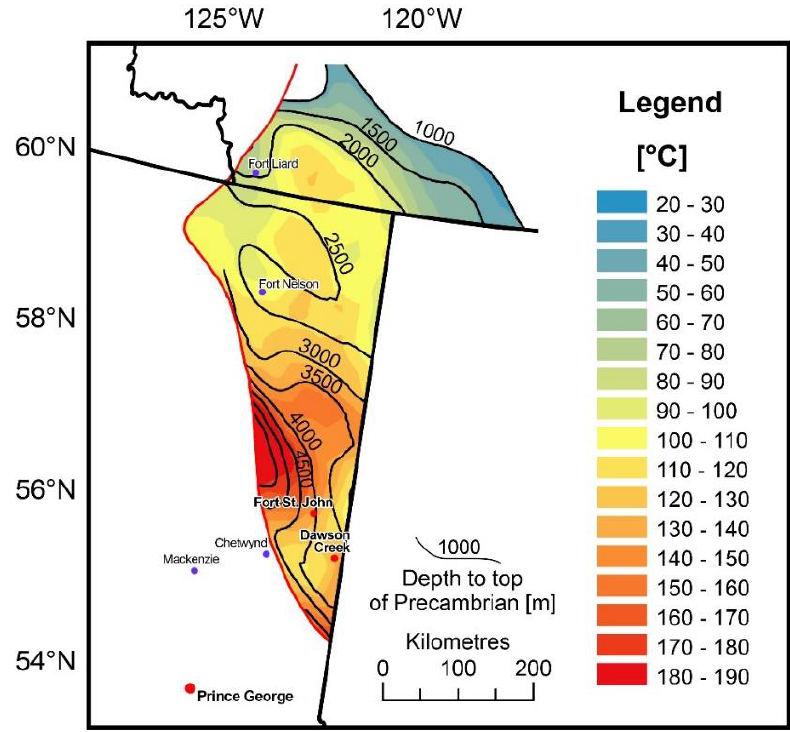
Figure A8. Temperatures top of Precambrian—NE British Columbia S. NWT WCSB. Energies 2021 , 14 , x FOR PEER REVIEW